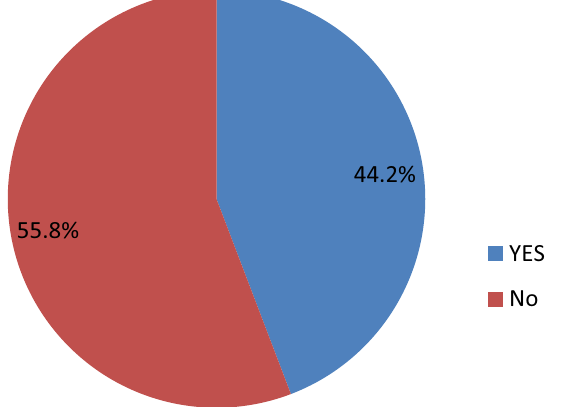
Figure 1. Magnitude of attention deficit hyperactivity disorder (ADHD).